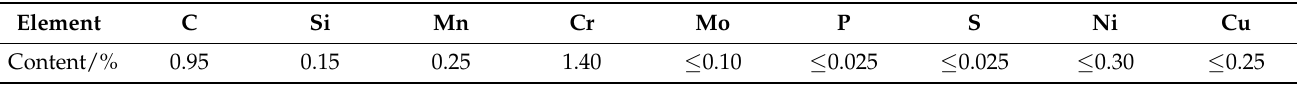
Table 1. Chemical element content of GCr15